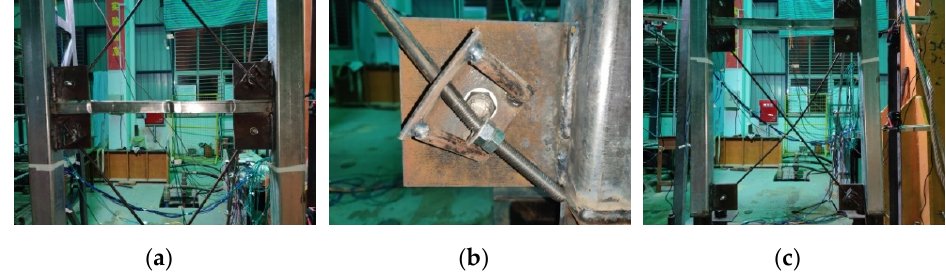
Figure 9. Test phenomena of FW-4 specimen: ( a ) Horizontal brace buckling; ( b ) Bending of the flexible bracings; ( c ) Brace deformation at the end of the test.